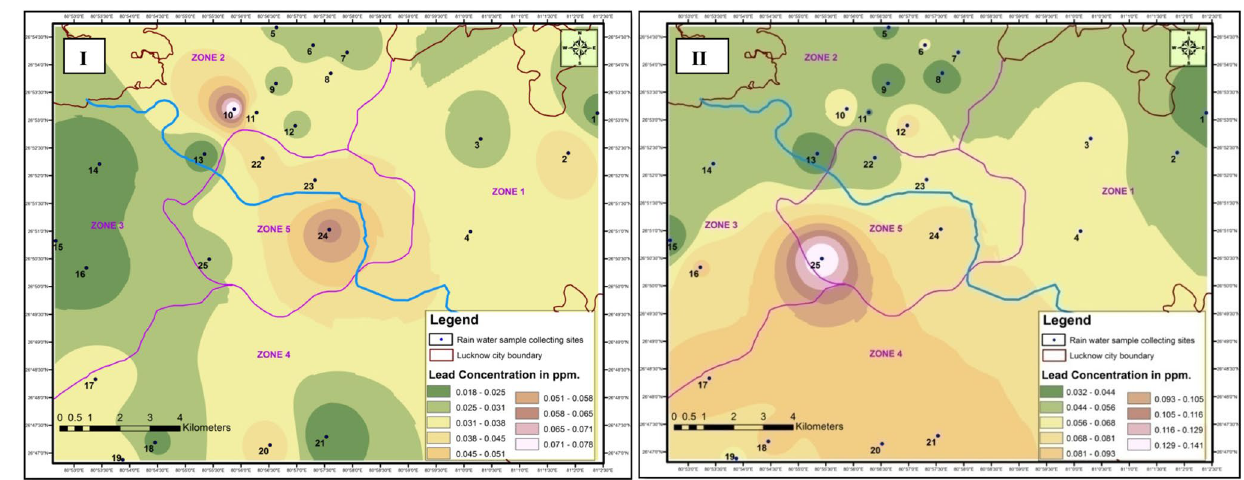
Fig. 5 Contour Map of lead values at five zones of Lucknow city during first (I) and second (II) rainfall